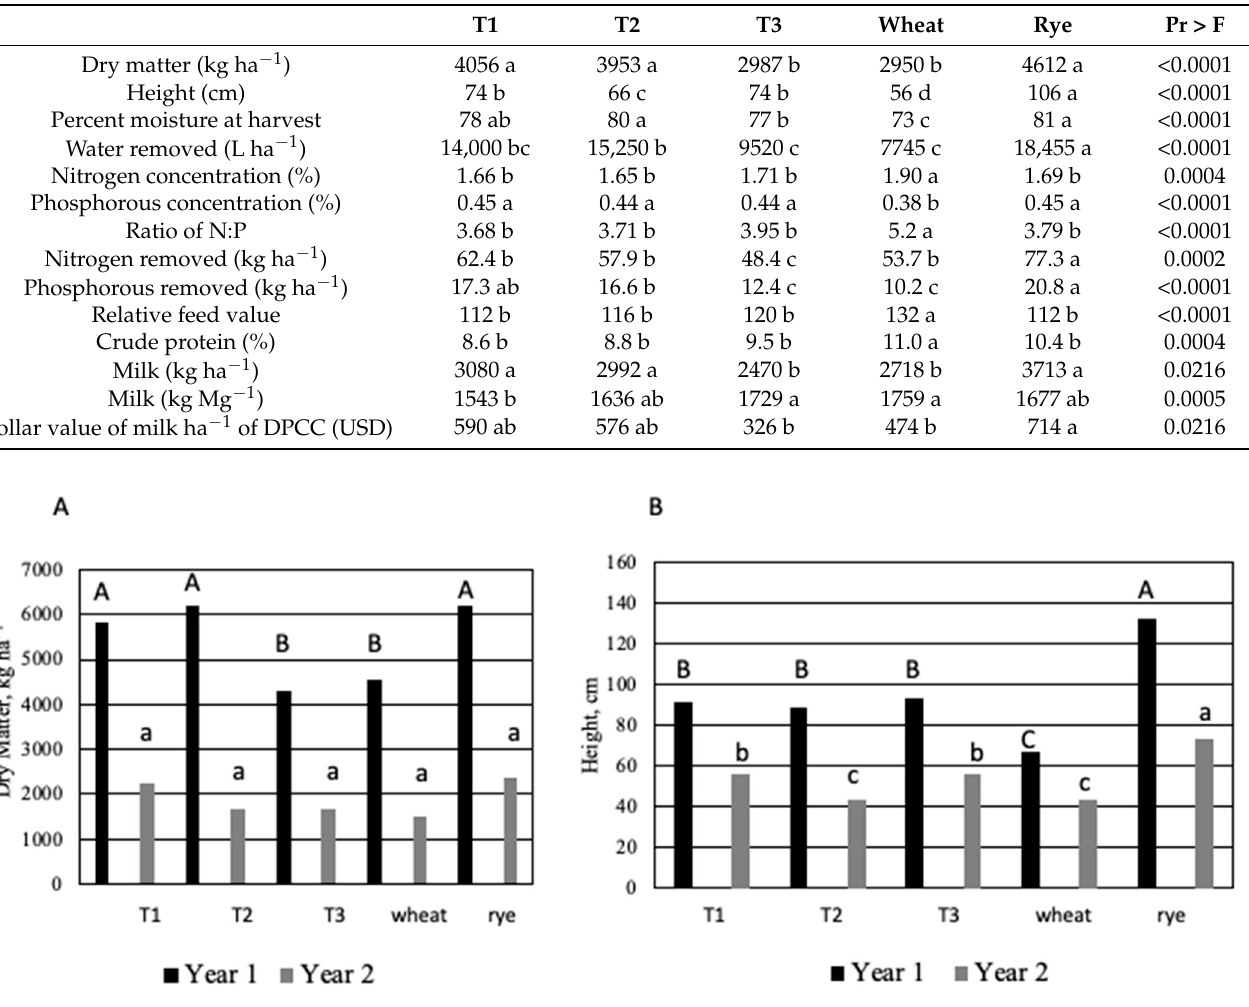
Table 2. Biomass yields, moisture contents, nutrient recoveries, and quality of DPCC species at harvest. Means separated by Tukey’s HSD range test. Within the same row, values followed by different letters are statistically different. Values are averages of two years. Trical 815 (T1); NE426GT (T2); T3 (variety not stated).